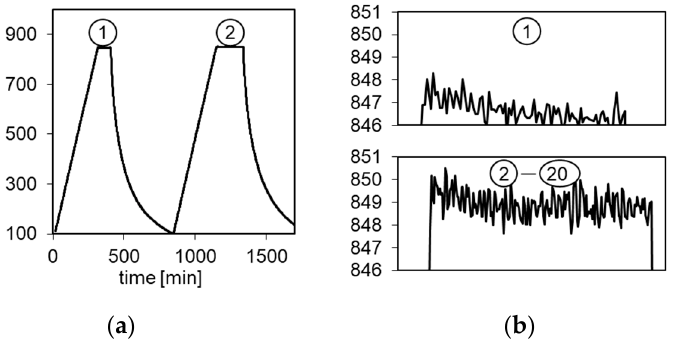
Figure A4. Measured temperature-time profile during thermal cycling treatment of tubular mem- branes. The temperature oscillation during the holding time was around ± 1 K. After adjusting the control parameters during the first cycle ( a ), a mean isothermal temperature of 849 °C was obtained in the following cycles ( b ).